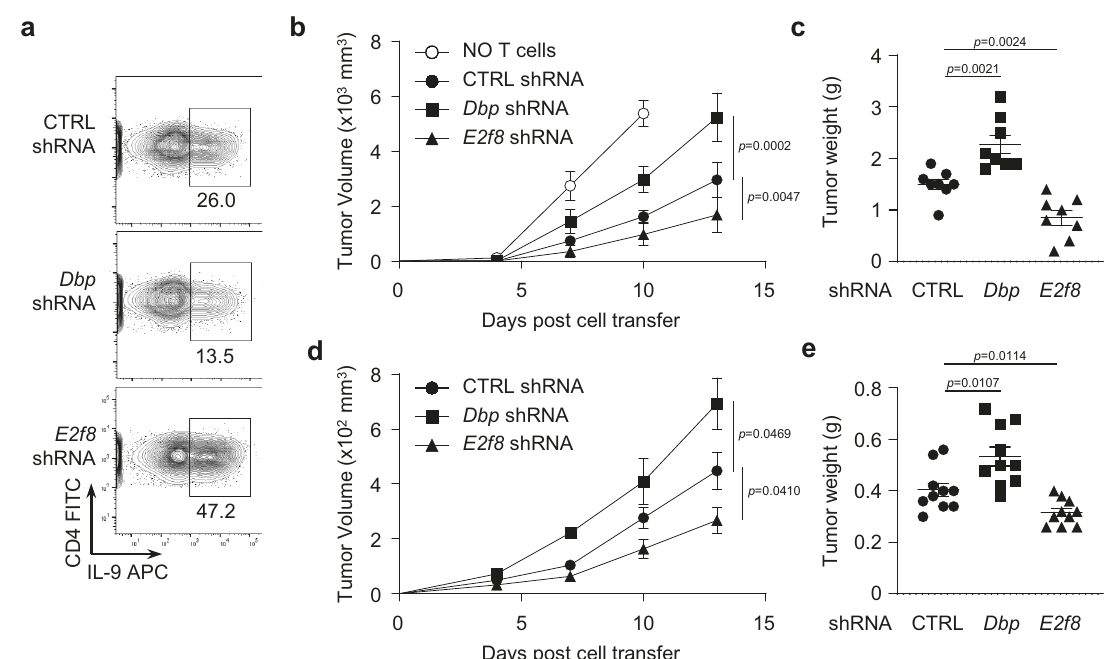
Fig. 6 | DBP and E2F8 play opposite roles of Th9 cell mediated anti-tumor activity in vivo. a Intracellular staining of IL-9 produced by CD4 + T cells with indicated shRNA transfection before cells were transferred into Rag1 − / − mice. Tumor growth over time in 8-week-old male and female Rag1 − / − mice given intra- venous transfer of CTRL, Dbp or E2f8 shRNA treated CD4 + T cells along with simultaneous subcutaneous injection of b B16 melanoma cells (male: n =5 and